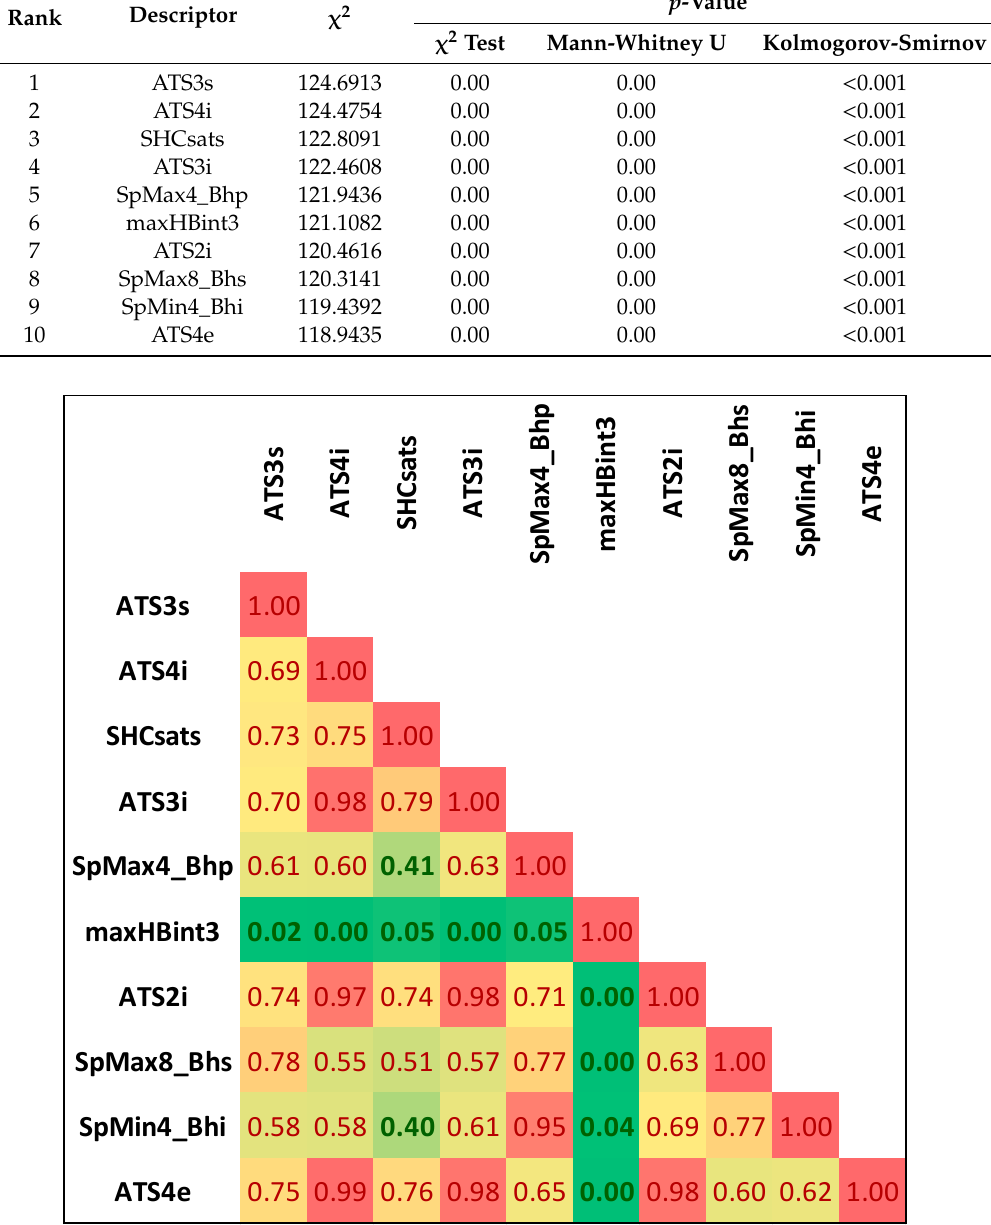
Figure 1. The correlation matrix of selected descriptors.